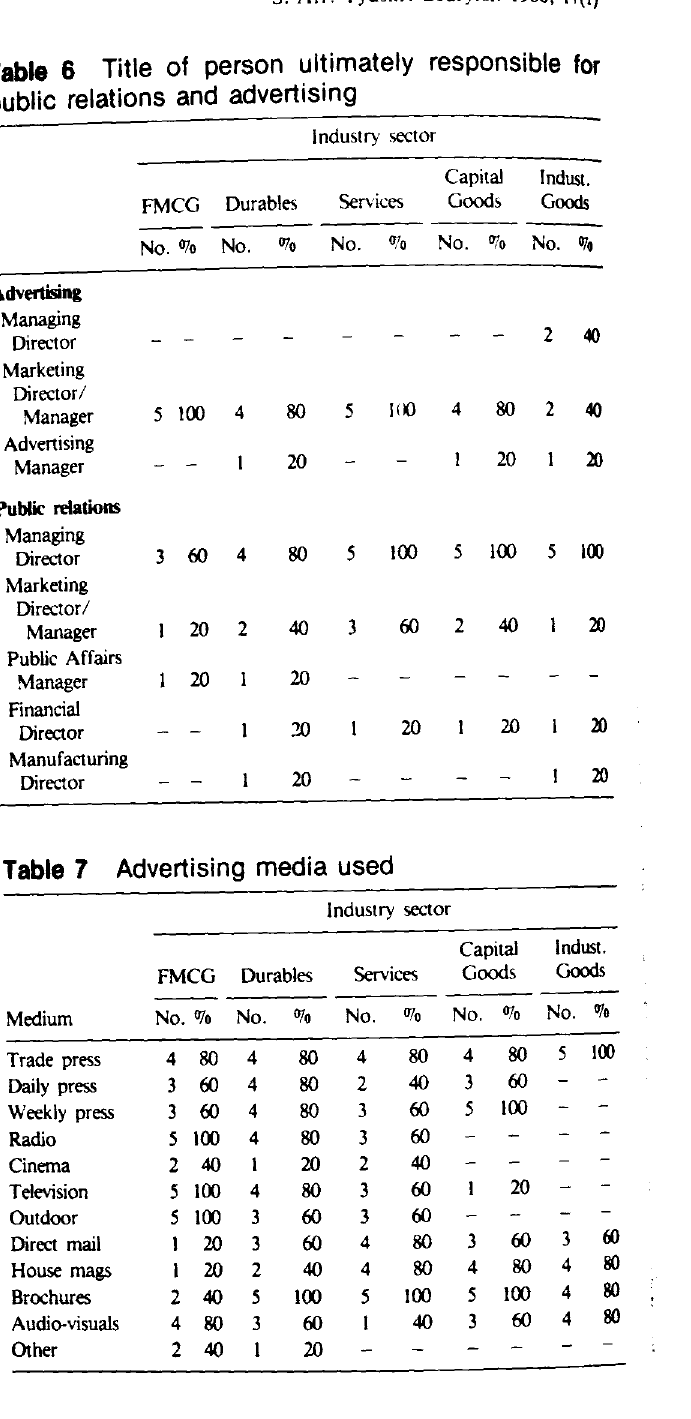
Number of finns using advertising and public relations agency